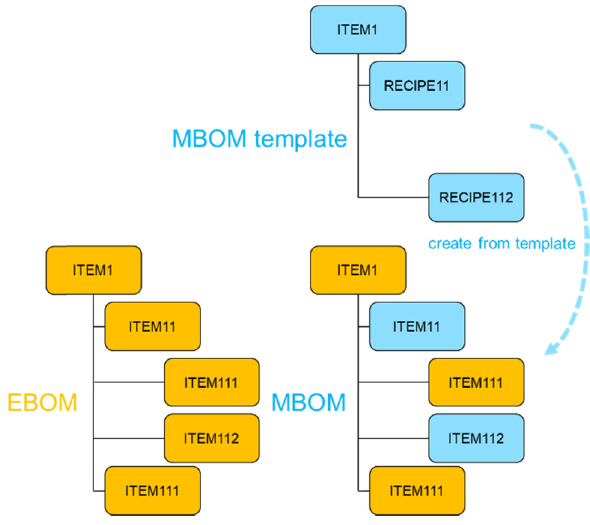
Figure 1: From EBOM to MBOM with a recipe and MBOM template ( adapted from [ 16 ])